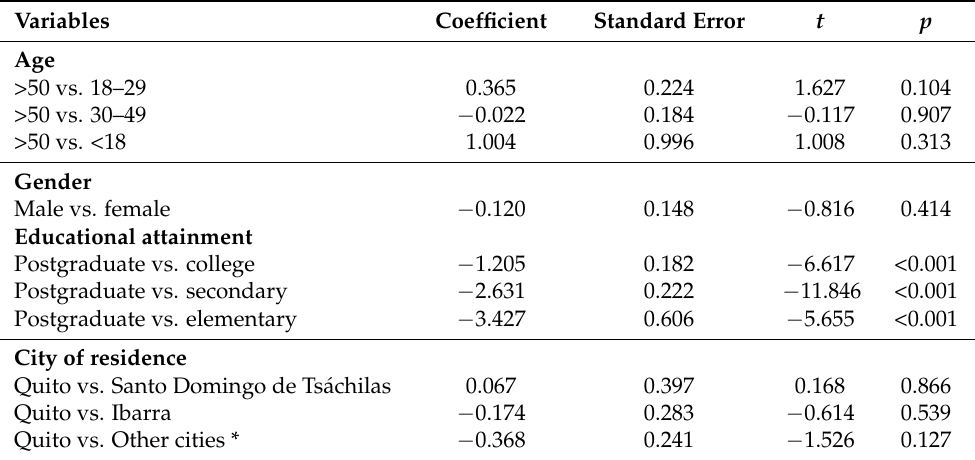
Table 2. Outcomes of the multiple linear regression on factors associated with low scores concerning COVID-19